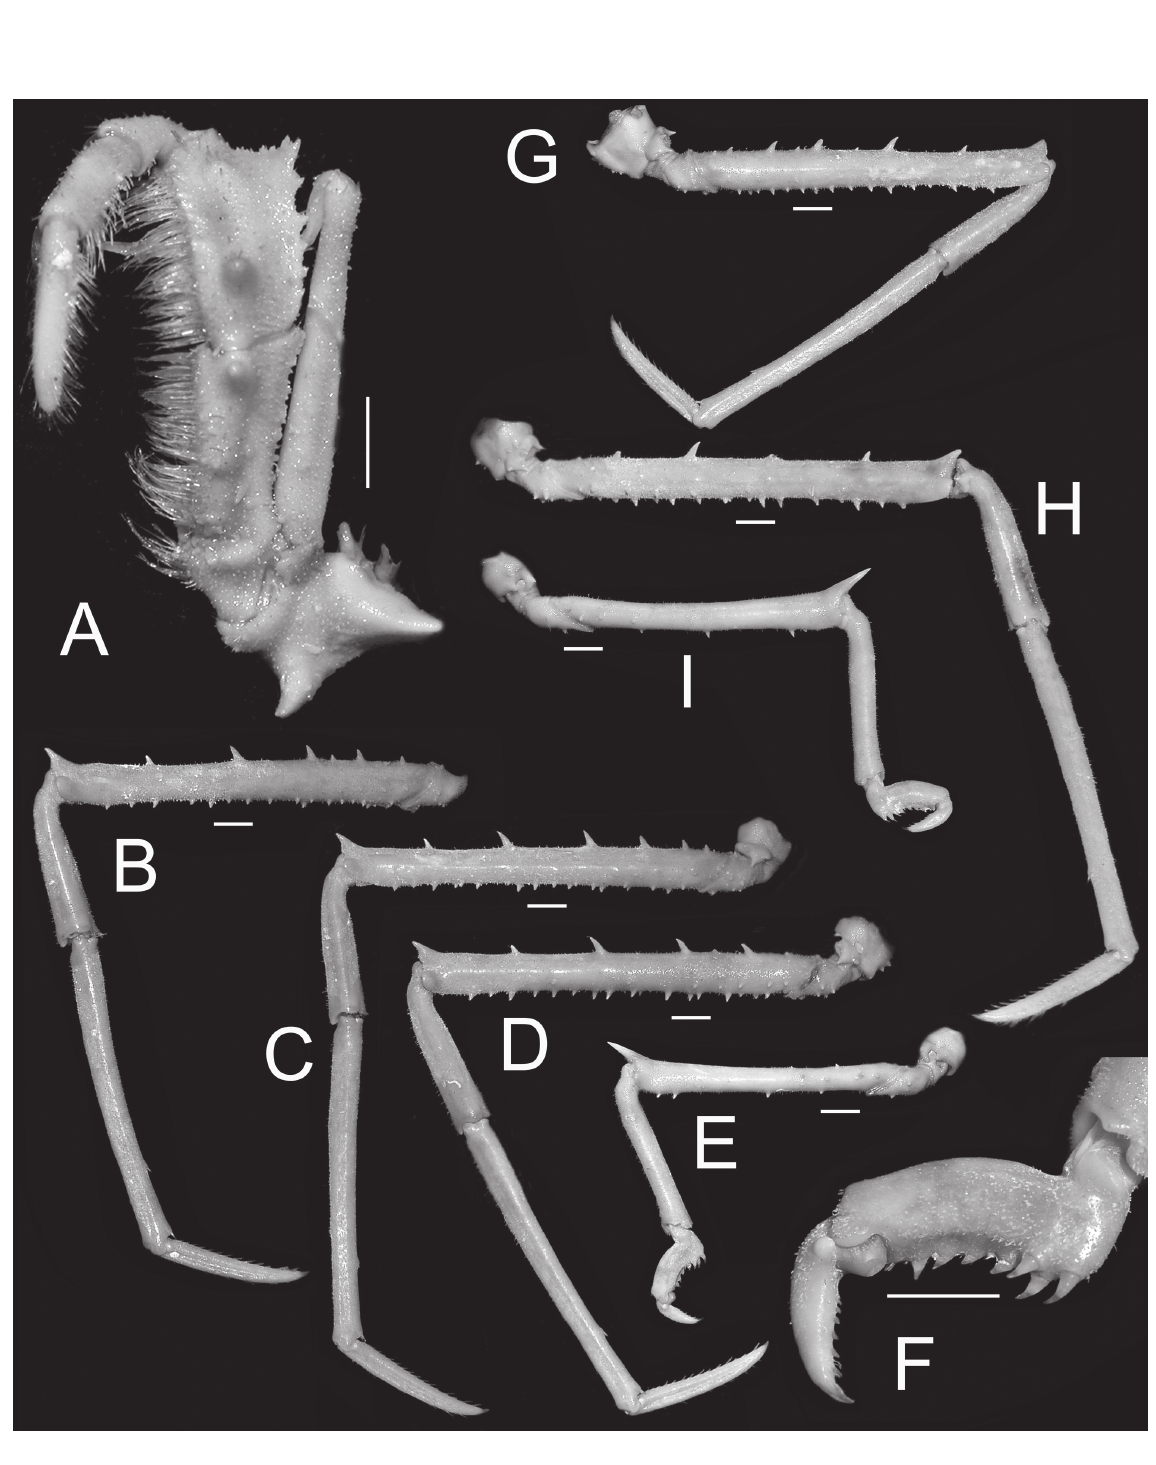
Fig. 10. Moloha grandperrini Guinot & Richer de Forges, 1995. Holotype, ♂ (cl 46.5 mm, cw 39.0 mm) (NHM 1948.9.7.27), Maldives. A . Left third maxilliped. B – E . Left P2–P5, respectively. F . Left P5 subchelate dactylus and propodus. G . Right P2. H – I . Right P4 and P5, respectively. Scale bars =